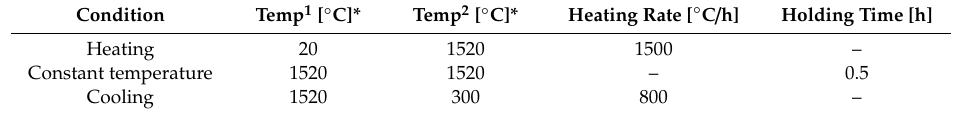
Table 2. The sintering protocol for Zenostar ® Translucent, applicable for a single crown